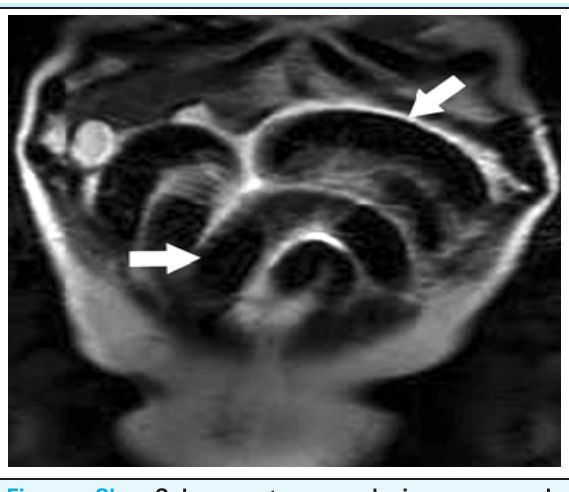
Figure 8b. Subsequent coronal image reveals numerous proximal dilated loops of small bowel (white arrows), which is consistent with diagnosis of small-bowel